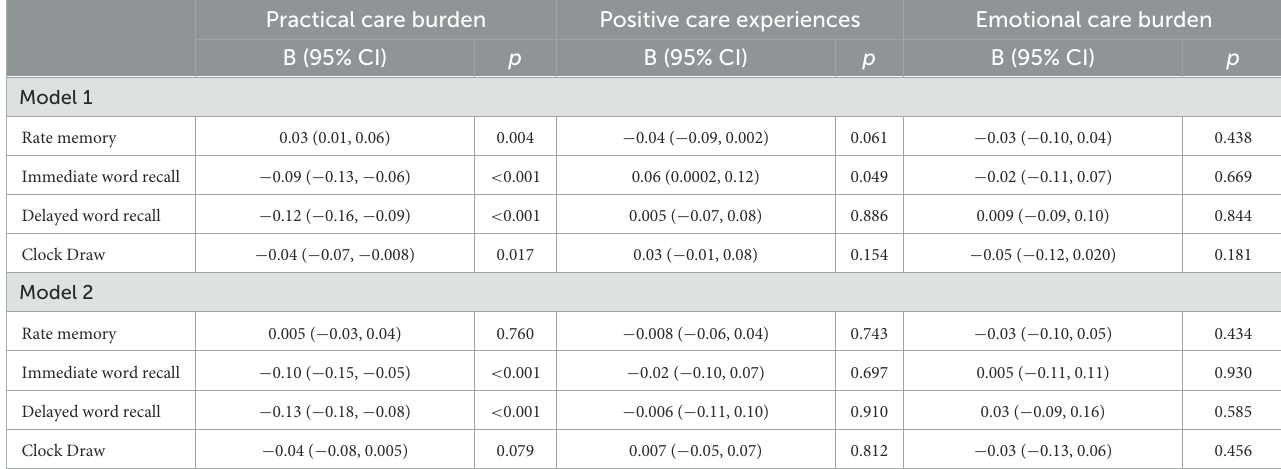
TABLE 3 Association between caregiver experience and care recipient cognitive test performance. Practical care